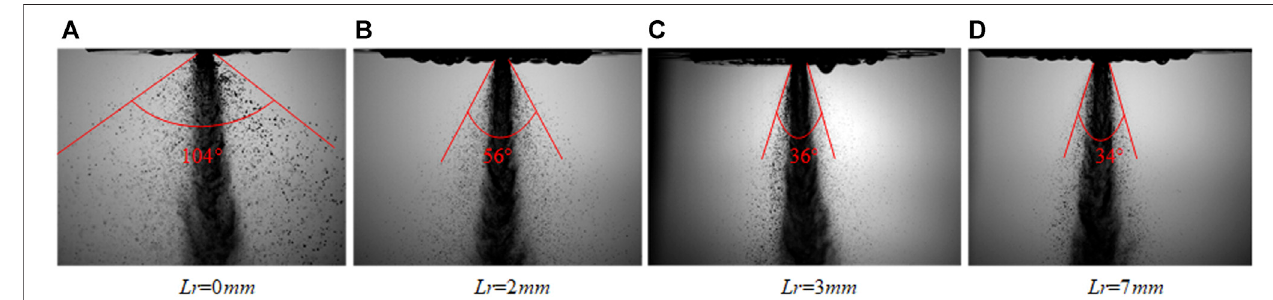
FIGURE 5 | Stable spray patterns with various recess length ( m l (cid:2) 20 g/s, m g (cid:2) 12.6